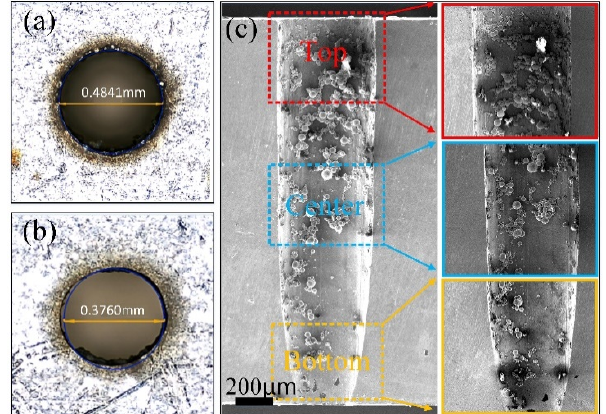
Figure 7. Morphology of microholes with a taper angle of 3.09°: ( a ) microhole entrance; ( b ) microhole exit; ( c ) microhole cross section. Table 3. Mass ratios of di ff erent elements at the top, center and bottom of the microhole cross section. Table 4. Mass ratios of different elements at the top, center, and bottom of the microhole cross section. Element